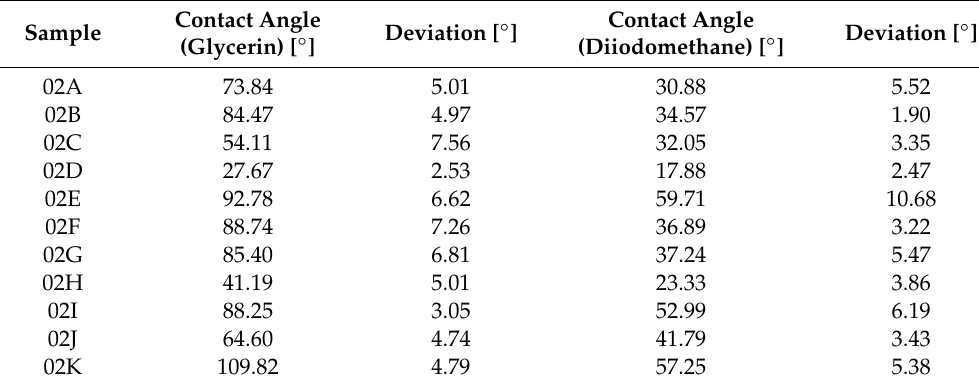
Table 8. Wetting angles of oxide coatings produced in the anodizing process and thermo-chemical treatment for glycerine and diiodomethane.